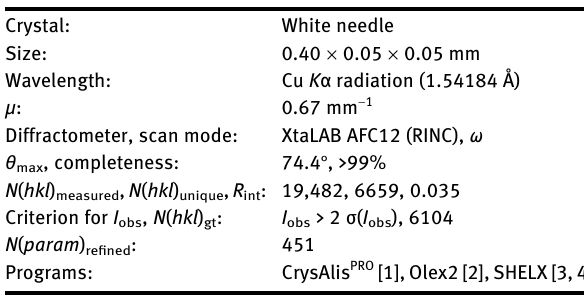
Source of material